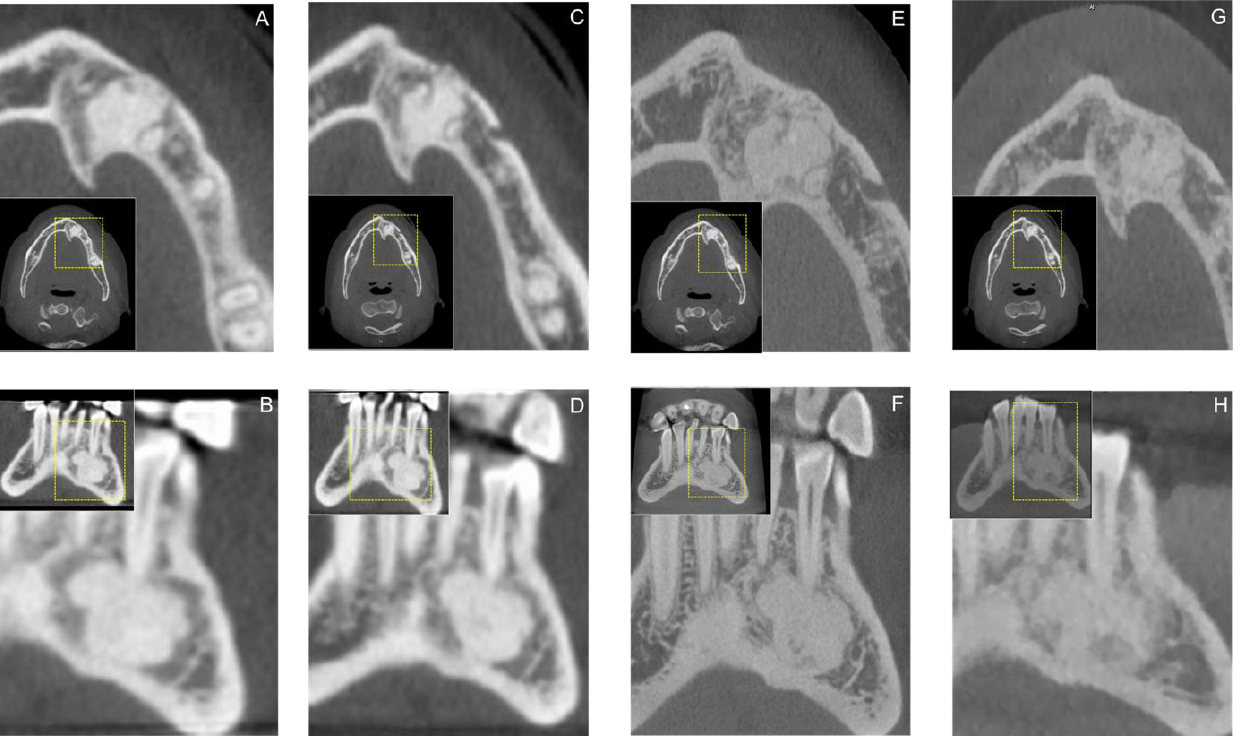
Figure 4. Axial ( A , C , E ) and Coronal ( B , D , F ) reconstructions of a study participants cone-beam computed tomography (CBCT) demonstrating annual radiological follow-up of cemento-osseous dysplasia. Additionally, the most recent follow-up on axial ( G ) and coronal ( H ) CBCT reconstructions of the region of interest using a low-dose imaging protocol is shown. For orientation, the dotted rectangles in the corner show the enlarged area of the region of interest. Ossifying fibromas have a neoplastic potential, with some neoplasms exhibiting sub- stantial growth potential [22]. It is usually diagnosed in the third to fourth decade of life,